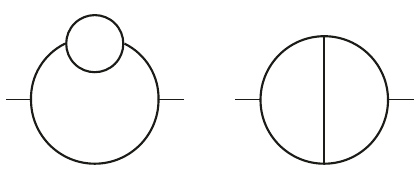
Figure 5 . Two-loop corrections to the self